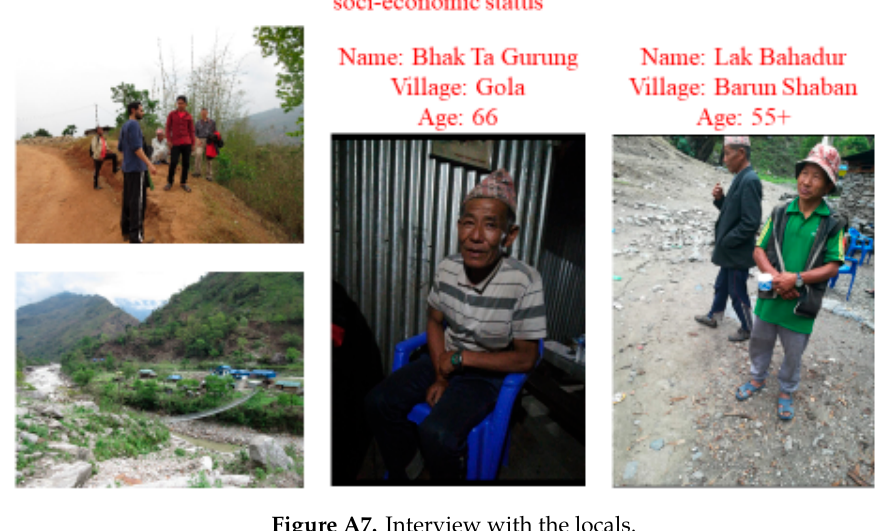
Figure A6. Field investigation route from Barun Khola to lower dam site .